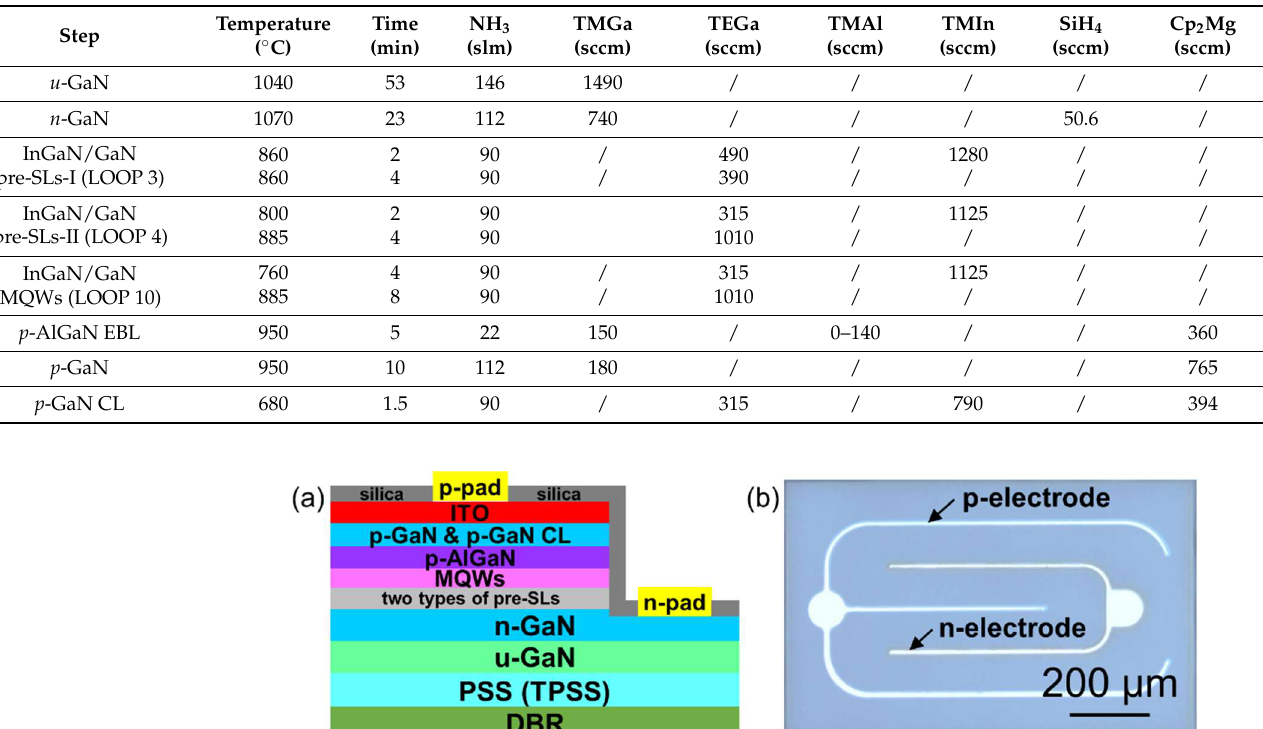
Table 1. The growth conditions of the epitaxial structure in the MOCVD process.